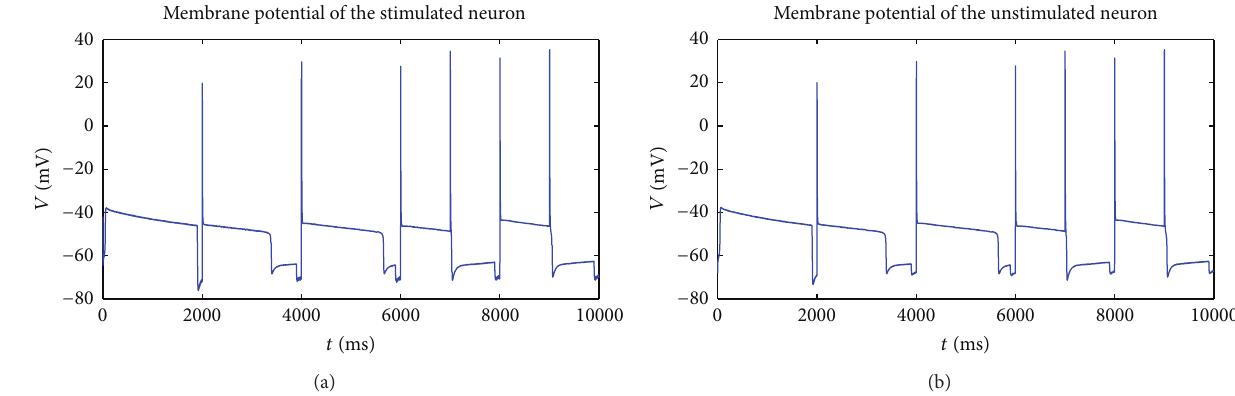
Figure 11: Membrane potential of a neuron is stimulated directly or indirectly,